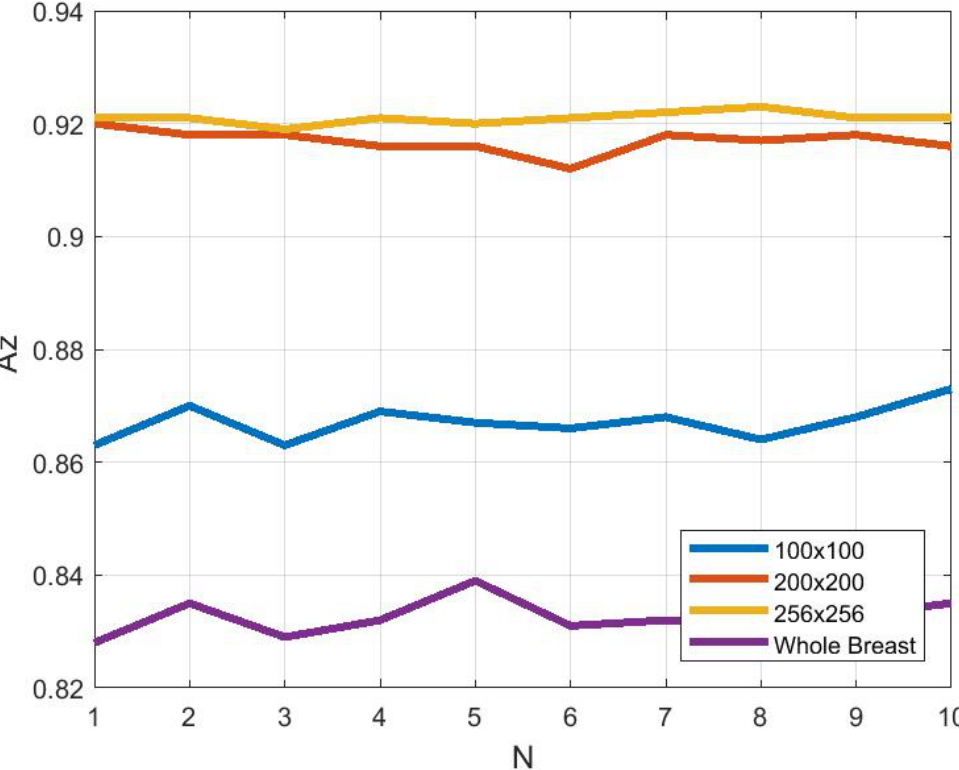
Figure 10. Area under ROC curve ( A z ) as a function of ROI size (N indicates a distinct